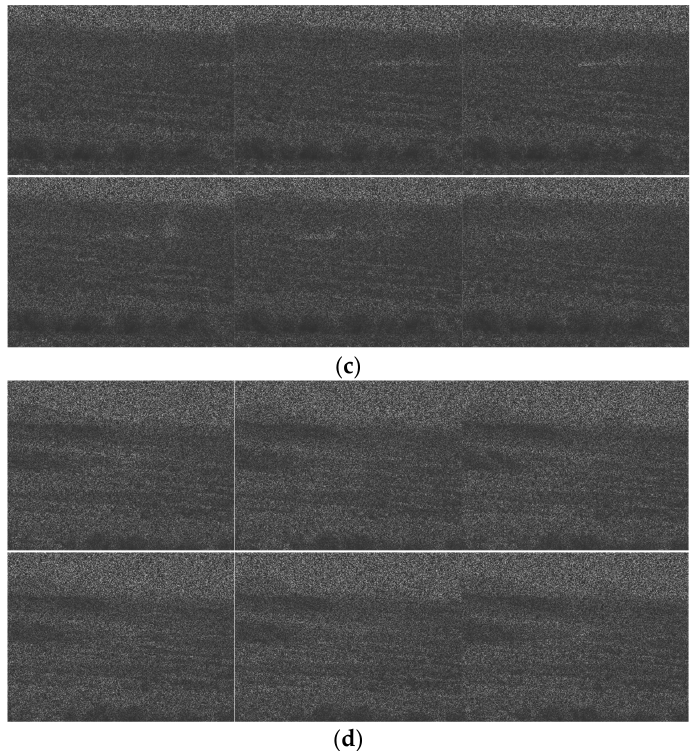
Figure A2. Tracking results for frames 1, 63, 126, 189, 252, and 315 for the PCE 25 (optical video) case. The vehicle is SUV. No detections are observed in the sampled frames. ( a ) 1000 m; ( b ) 2000 m; ( c ) 2500 m; and ( d ) 3500 m.